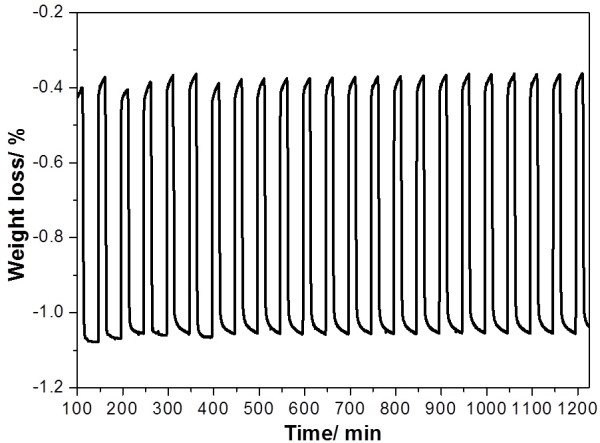
TG profiles during measurement ofOSC at 600°C for Ce0.5Zr0.3Al0.2O1.9 (1,000°C, 20 h) after 22 cycles. The profiles show oxygen release/storage properties.